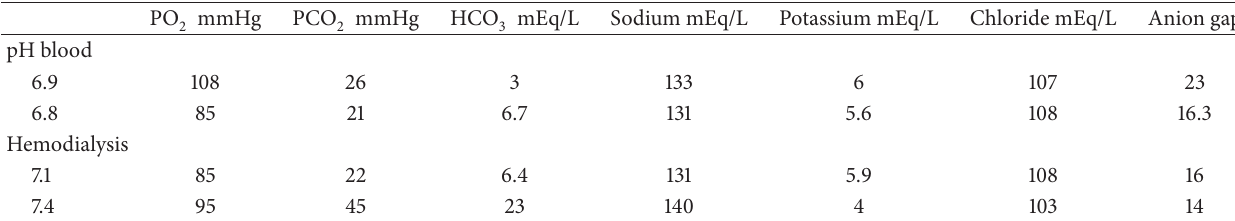
Table 1: Evolution of acid base status.